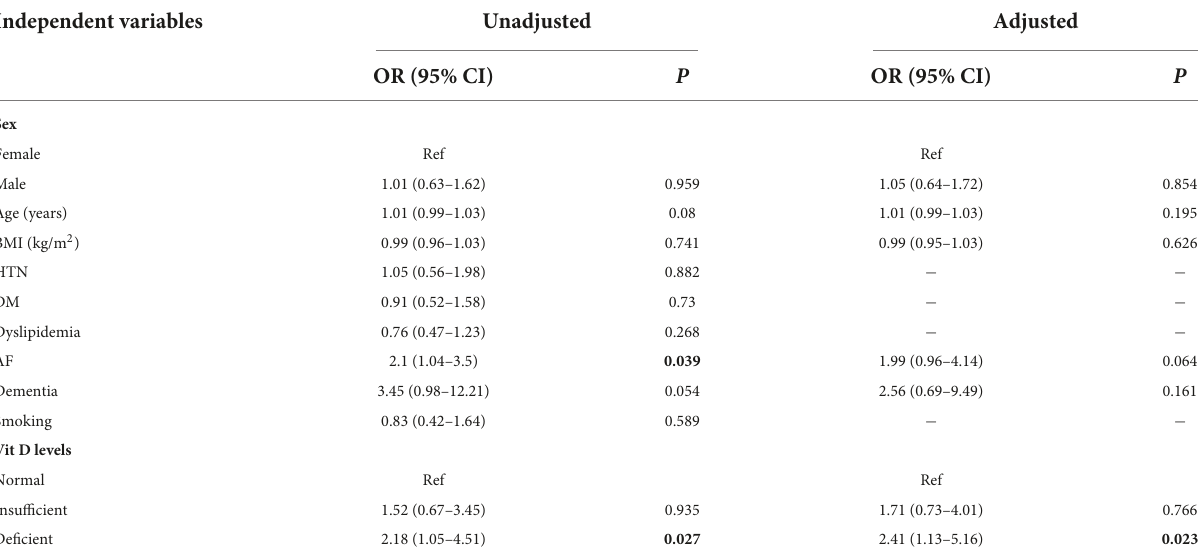
TABLE 4 Simple and multiple logistic regression analysis for association of independent variables with poor functional outcome (mRS ≥ 3). Independent